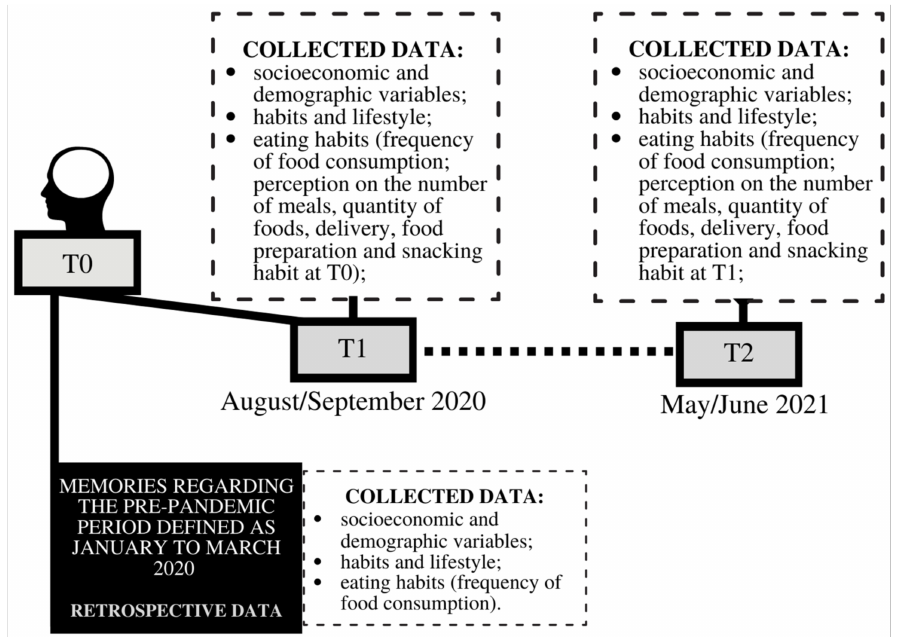
Figure 3. Detailing the periods and variables collected in each research